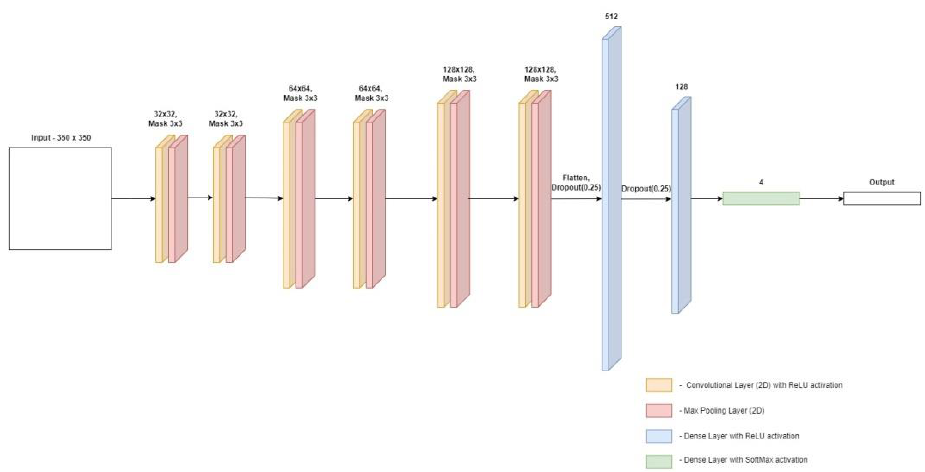
Figure 10. Architecture of the third convolutional neural network model.